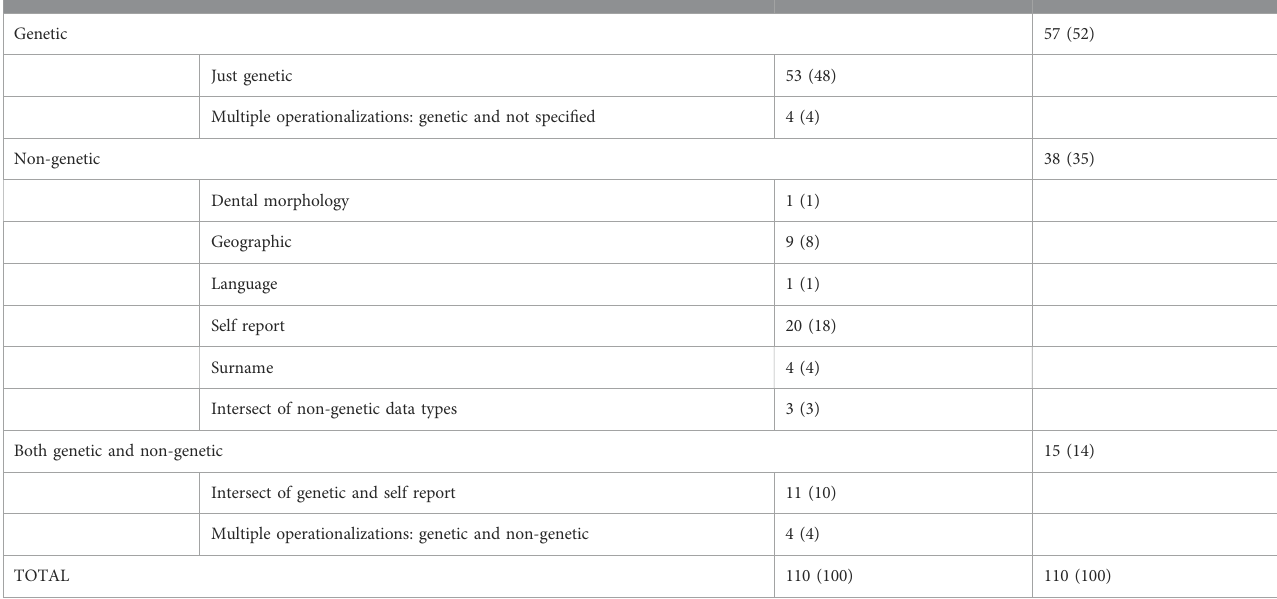
TABLE 3 Types of data used to operationalize ancestry in articles Type of data used to operationalize ancestry